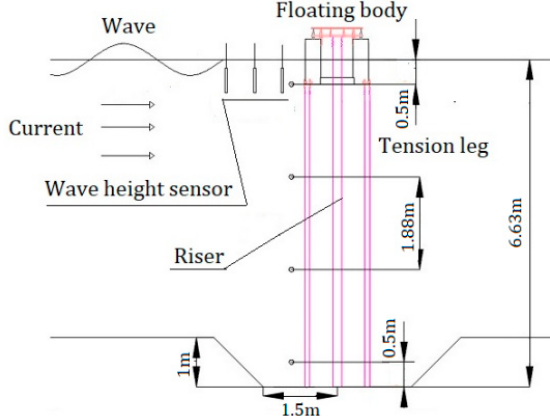
Figure 1. Schematic Diagram of Full Depth Mooring Test.